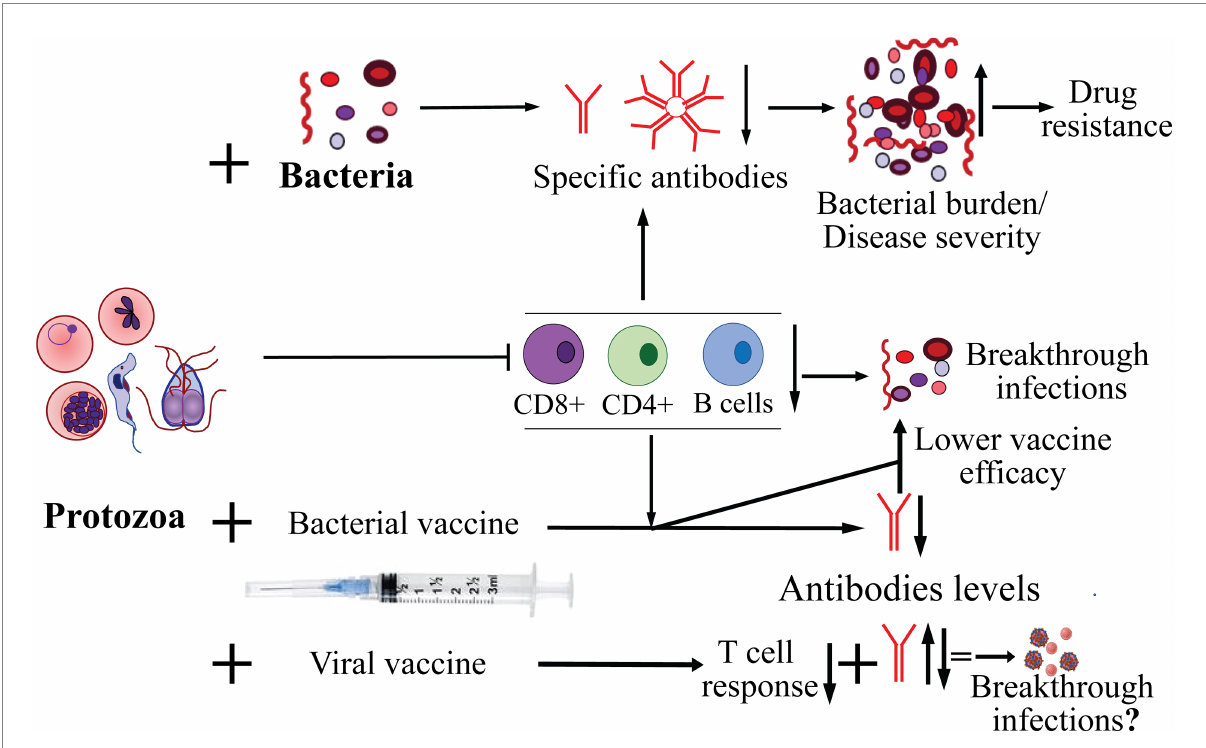
FIGURE 1 Effect of protozoan infection on adaptive immune response and co-infecting bacteria, and on effectiveness of bacterial and viral vaccines in protection from infection. The major pathogenic protozoa, such as Plasmodium , Babesia , Trichomonas and Trypanosoma , often cause suppression of adaptive immune response affecting both B and T cells. As a consequence, decrease in the specific antibody levels against co- infecting bacteria resulting in increase in burden of bacterial pathogens and exacerbation of severity of diseases they cause. Increased bacterial burden also enhances probability of emergence of resistance to antimicrobials. Diminished cellular and humoral immune response caused by acute to chronic infection by protozoa could also result in reduced efficacy/failure of vaccines against bacterial pathogens and may lead to breakthrough infections. Highly variable effects of protozoan infections with respect to antibody response to vaccines against different viral pathogens has been reported but their impact on breakthrough infections by the respective viruses remains to be investigated more